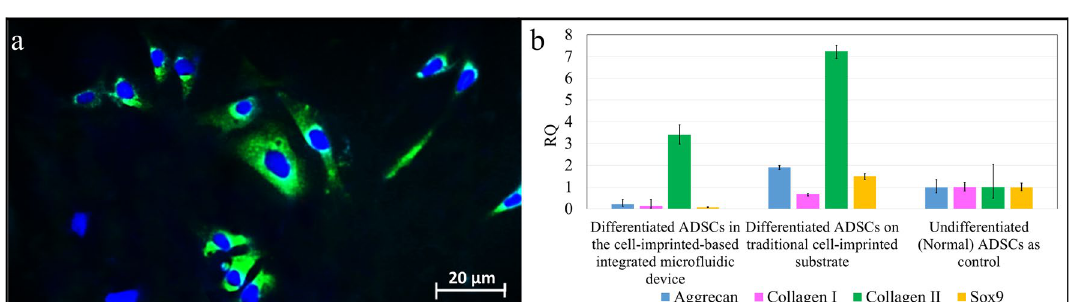
Figure 7. ( a ) Stained ADSCs in a 25 µm microfluidic chip on the cell-imprinted substrate with collagen II (green) and DAPI (blue) for the nucleus. ( b ) Quantitative real-time PCR analysis: gene expression profile of differentiated ADSCs in the cell-imprinted-based integrated microfluidic device and on the traditional cell- imprinted substrate and freshly isolated ADSCs which were grown on standard cell culture flasks as control; different genes (aggrecan, collagen I, collagen II, and sox9) are expressed